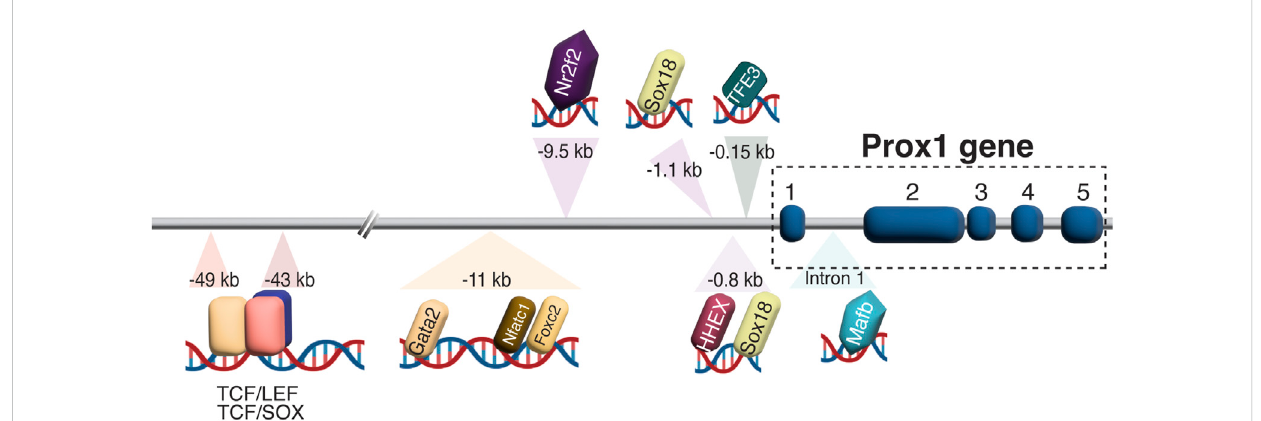
FIGURE 4 Prox1regulationinLECdevelopment.Schematicrepresentationofbidingmotifsformultipletranscriptionsfactorsandregulatorsintheupstreamof the Prox1 gene is shown. In the − 43/ − 49 kb region, TCF:LEF and TCF:SOX overlapping binding sites are found, suggesting a possible competition between LEF and SOX factors to bind to the same